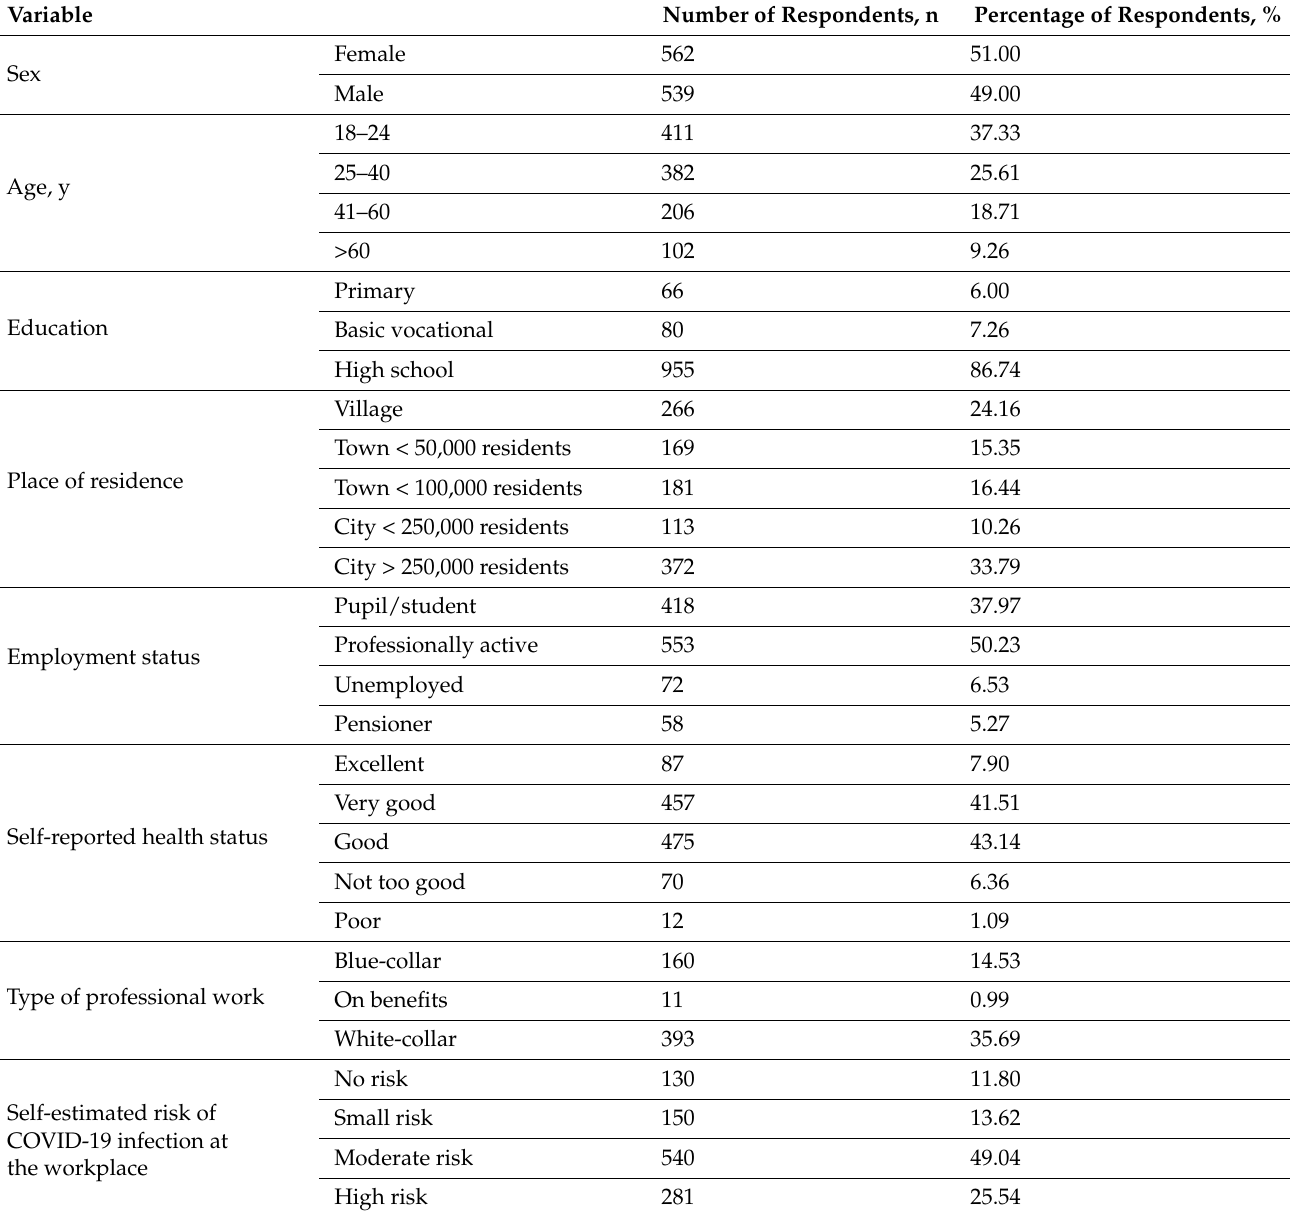
Table 1. Sociodemographic characteristics of the study population ( n =